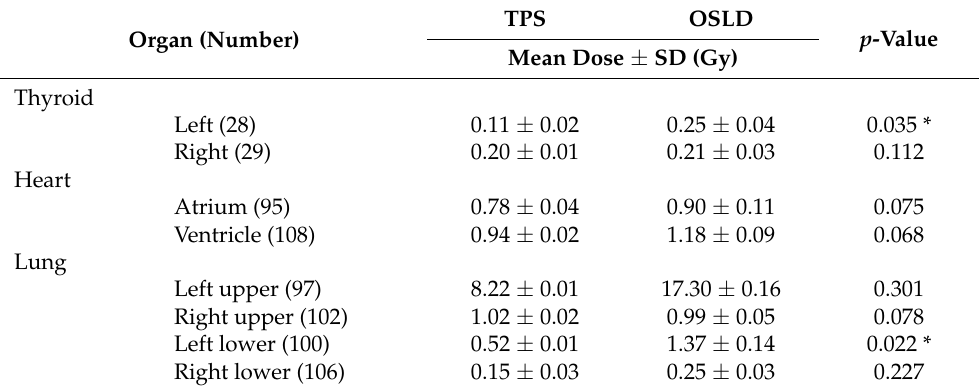
Table 4. Comparison of the TPS calculated doses and the doses measured by OSLDs of the IMRT plan.